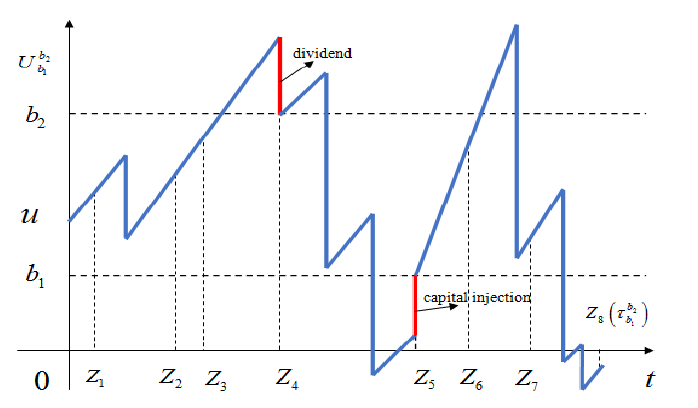
Figure 1. A sample path of U b 2